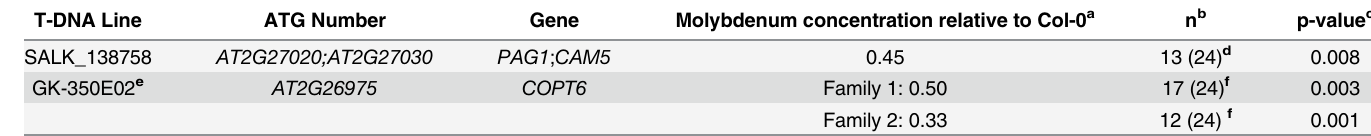
Table 3. T-DNA insertion lines with significant associations to the mean leaf molybdenum concentrations. T-DNA